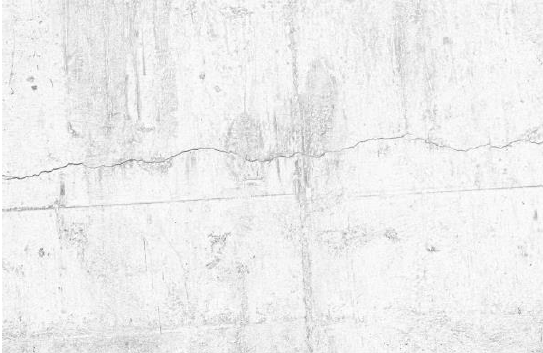
Figure 18. Drawing an ROI with concrete spalling